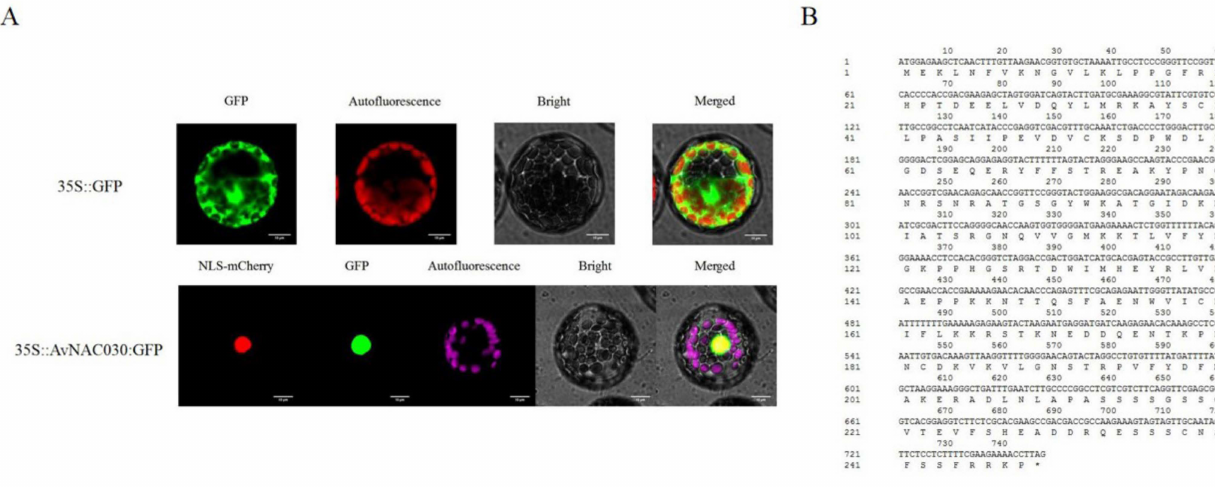
Figure 6. Subcellular localization of AvNAC030. ( A ) The vector control ( 35S::GFP ) and fusion protein construct 35S::AvNAC030:GFP were introduced into the Arabidopsis protoplast. ( B ) CDS and peptide sequence of VvSAUR041